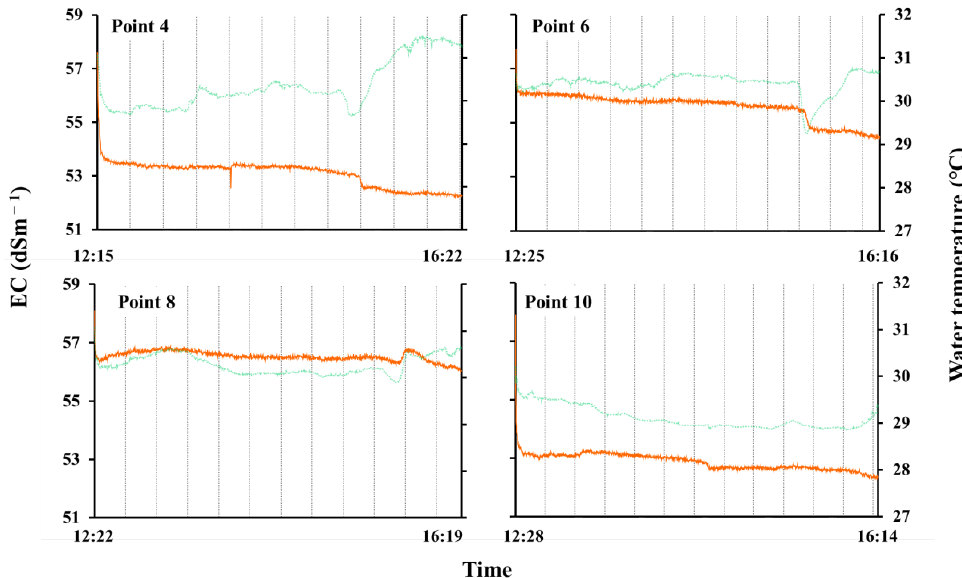
Figure 5. Changes in EC and water temperature at 4 points of a creek water flowing in a Rhizophora Rhizophora mucronata community on Moucha Island, Djibouti (12 September 2019). The orange mucronata community on Moucha Island, Djibouti (12 September 2019). The orange lines show EC and the green lines show water temperature. lines show EC and the green lines show water